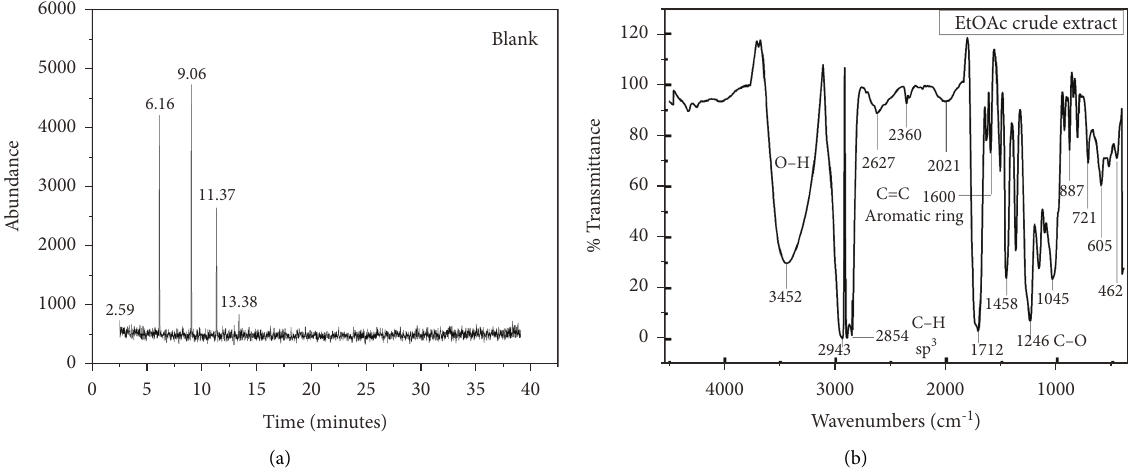
Figure 11: GC-MS chromatogram for the blank (a) and FTIR spectra for the EtOAc crude extract (b).